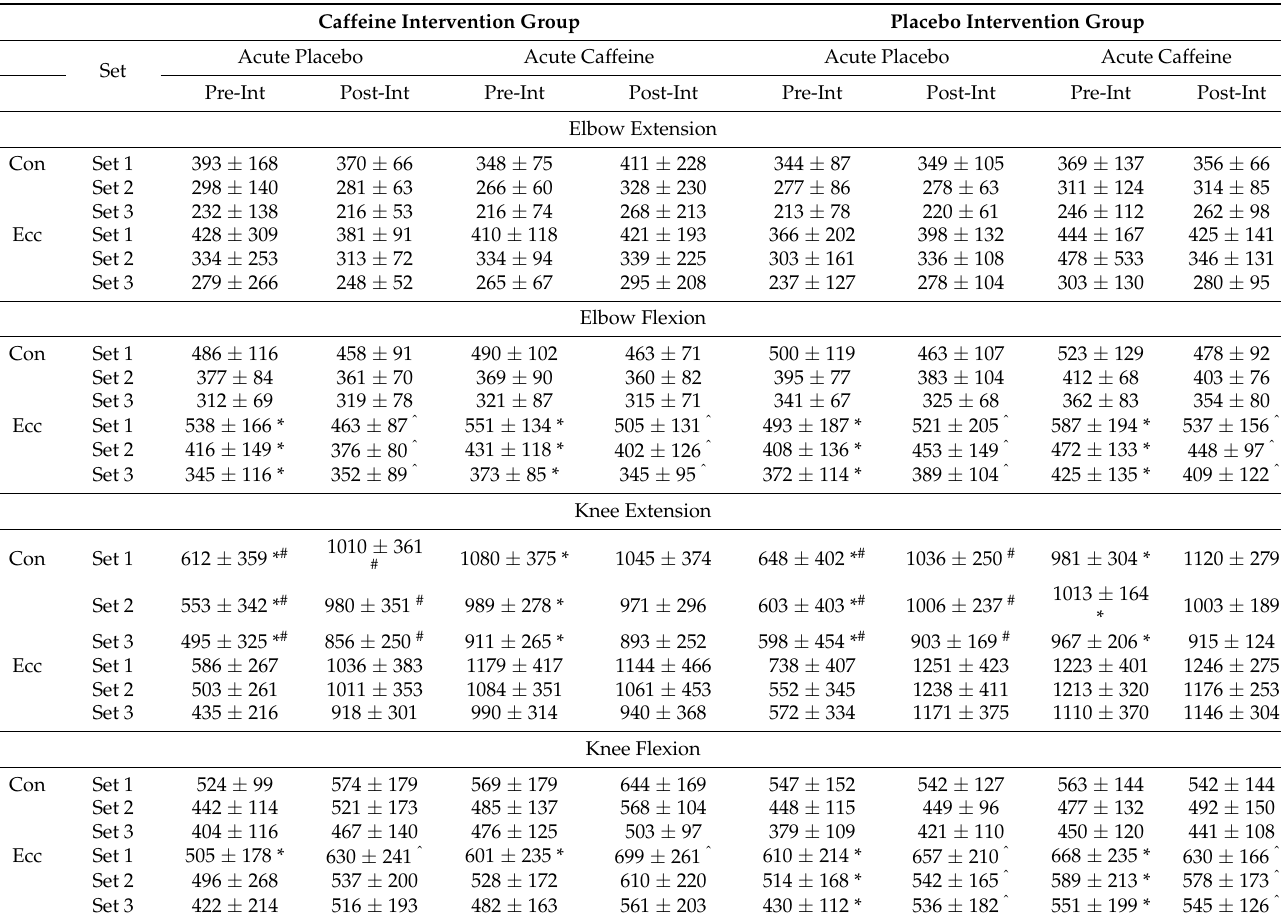
Table 3. Acute effect of caffeine treatment (3 mg · kg − 1 ) pre and post-7-week resistance training on concentric and eccentric TW (Nm) of the elbow and knee flexors and